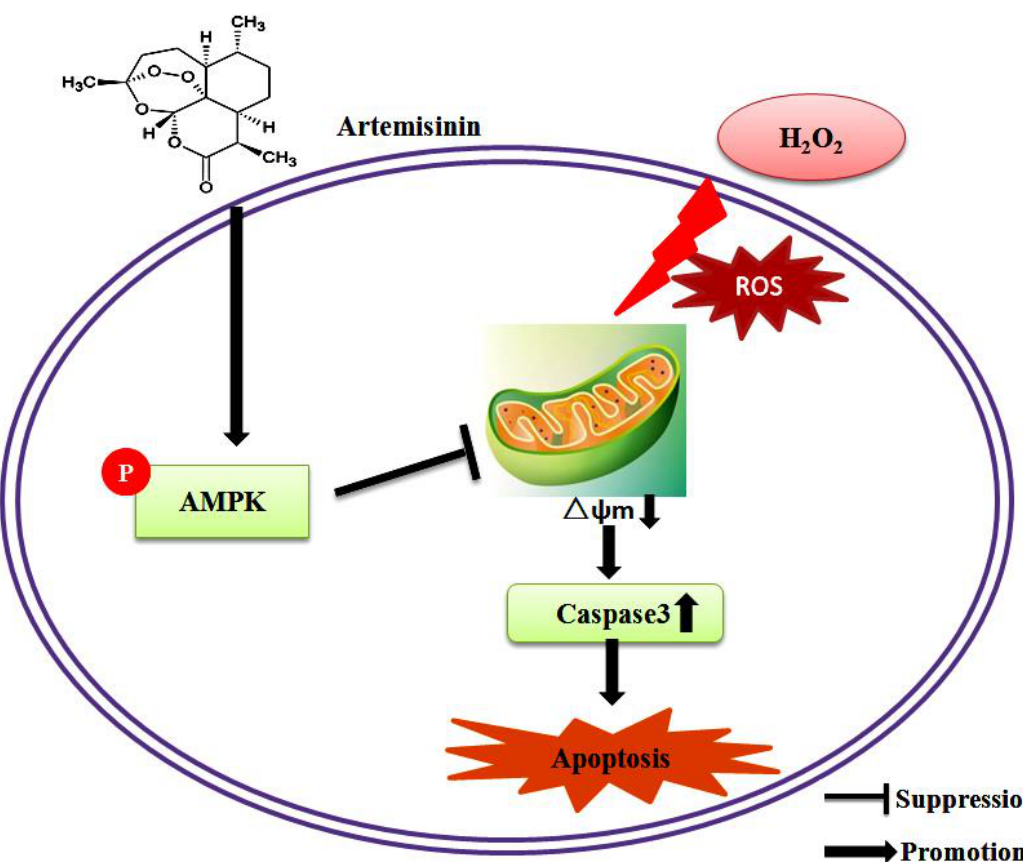
Figure 7. The possible mechanism of artemisinin. Excessive H 2 O 2 leads to excessive ROS